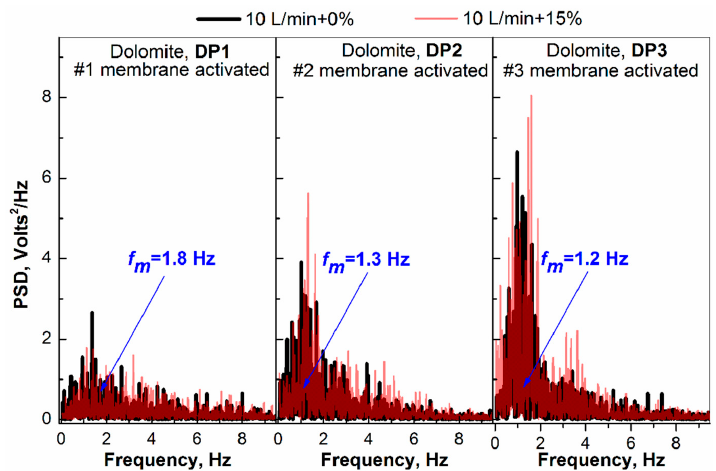
Figure 9. Comparison of the power spectrum of the differential pressure in the local bed section measured at gas addition and normal operational conditions. The other operational conditions were: T = 550 ◦ C, P = 0.1 MPa, H ini = 1.28 m, U = 0.09 m/s, addition rate = 1.5 L/min, calcined